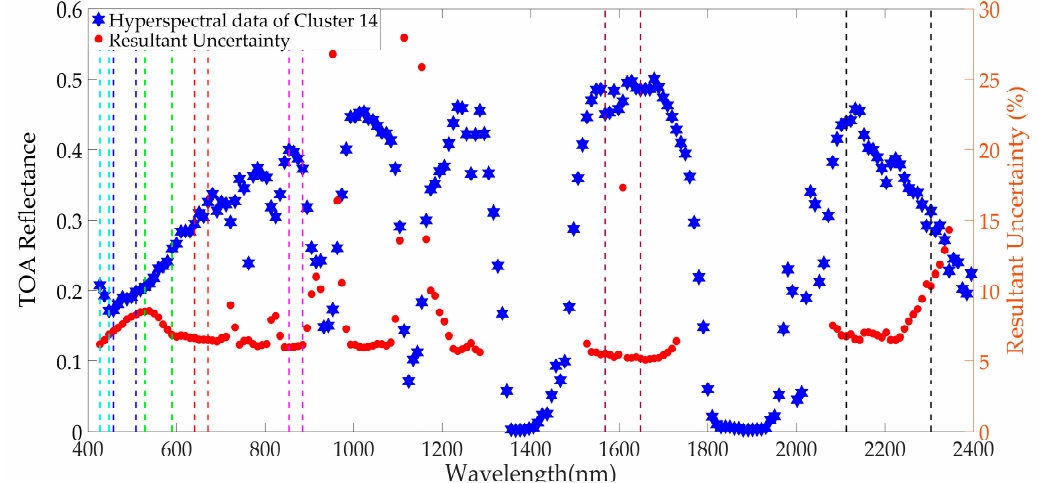
Remote Sens. 2019 , 10 , x FOR PEER REVIEW Figure A10. Estimated representative hyperspectral profile of Cluster 12 and its resultant uncertainty.